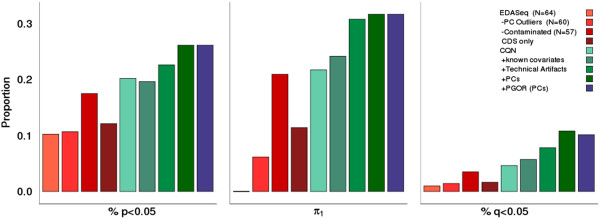
eQTL replication in brain data. Normalization by EDASeq (red bars) demonstrates that sample outlier removal improves eQTL replication and that whole gene annotation provides improved gene expression estimation than coding sequence (CDS) only. CQN normalization (green bars) provides slightly improved eQTL replication over EDASeq normalization and demonstrates the necessity of covariate inclusion in eQTL replication, particularly highlighting the necessity of accounting for unknown covariates. Per-gene outlier removal (PGOR, blue bars) does not hamper our ability to detect cis-eQTLs.